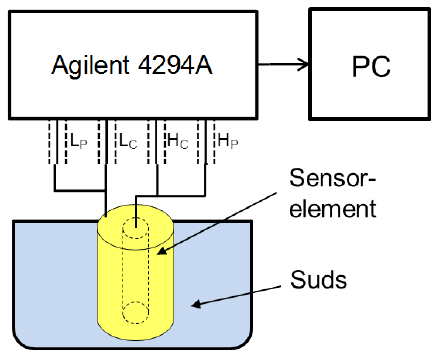
Figure 2. Measurement setup of Agilent 9294A for EIS measure- ments (Gruden and Kanoun, 2013b).